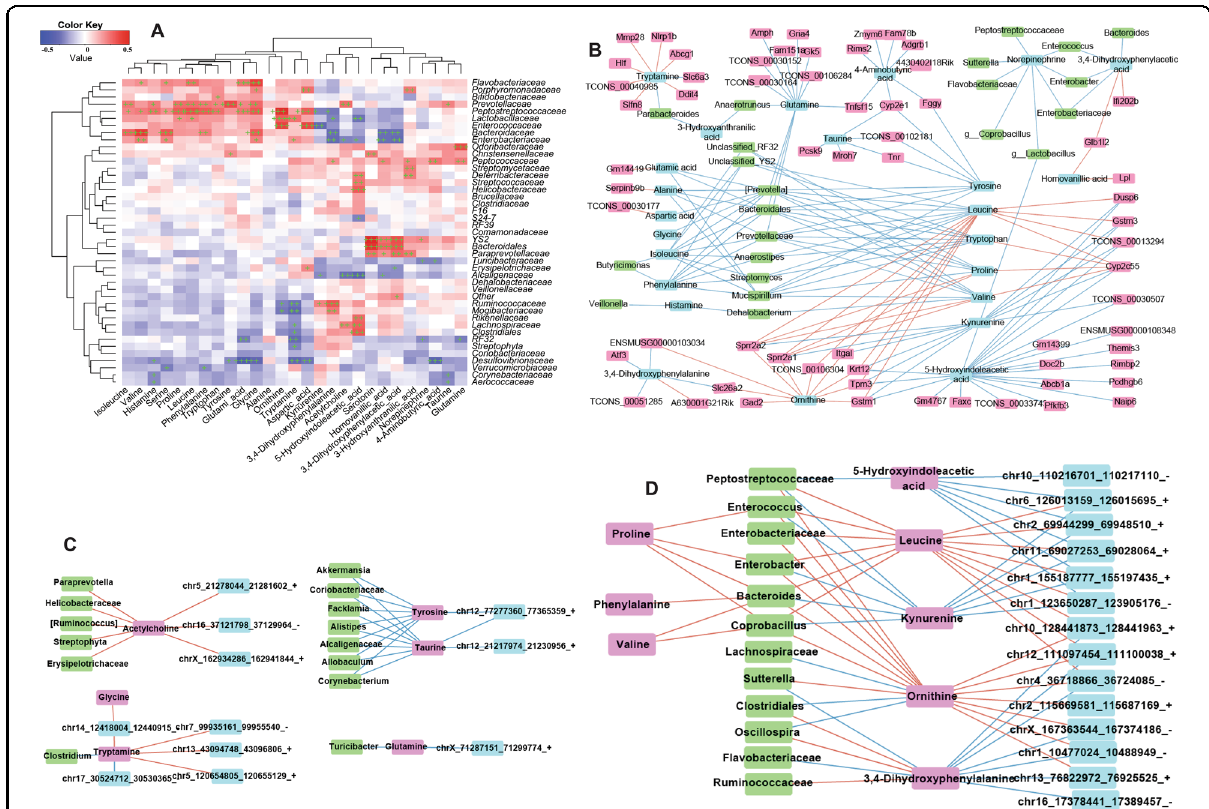
Fig. 5 Dysbacteriosis affects neurotransmitter metabolism by targeting the gut – brain axis in mice fed a diet high in sugar and fat for 4 months. A Combined data analyses between the gut microbiota (genera) and neurotransmitters in brain tissues. B Combined data analyses between the gut microbiota (genera), transcriptome in the intestine, and neurotransmitters in brain tissues. C , D Combined data analyses between the gut microbiota (genera), neurotransmitters, and circRNAs in brain tissues. Data are the mean ± SD of more than eight independent